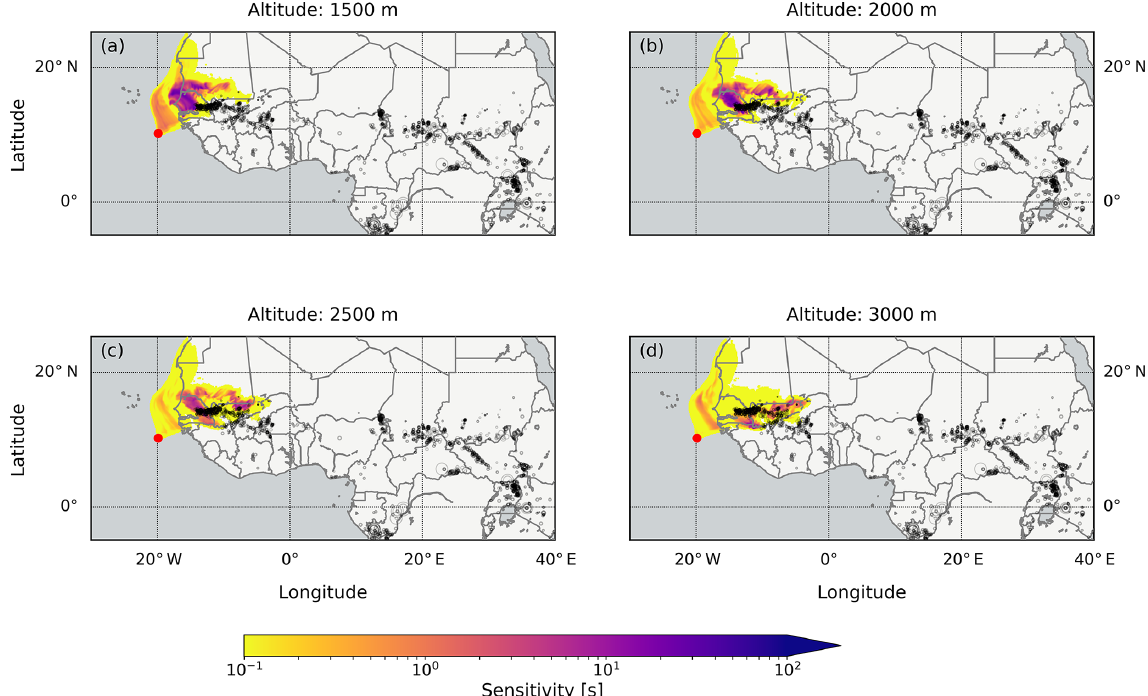
Figure 15. The emission sensitivity response function to the lowest 500m layer for air parcels arriving at the receptor position in different altitudes above the RV Maria S. Merian on 13 October 2016 at midday, indicated by red dots (compare Figs. 9 and 11). The emission sensitivities were integrated over 2d backwards. The black circles are fires which were detected between 10 and 12 October taken from the FINN database (Sect. 3.6). The circles are scaled with the calculated CO 2